Question: In a single sentence, describe what this figure presents.
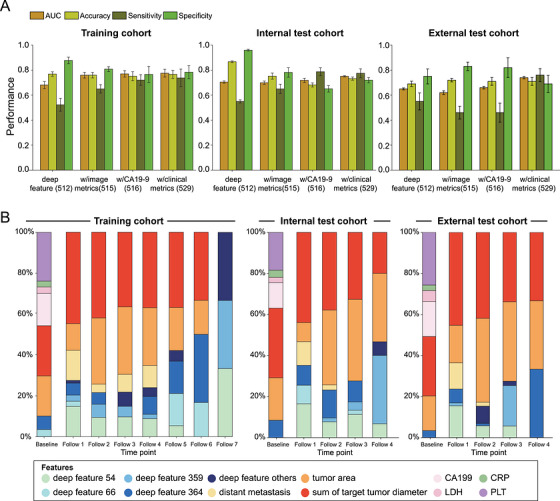
Answer: Performance comparison of models built with different feature combinations and feature contribution analyses. (A) Grouped bar charts showing the performance of different feature combinations. (B) Stacked bar charts of feature contributions across time points. X‐axis: follow‐up time‐points; Y‐axis: relative importance proportion. Color‐coded bars represent multimodal features. CRP, C‐reactive protein; LDH, lactate dehydrogenase; PLT, platelet count.